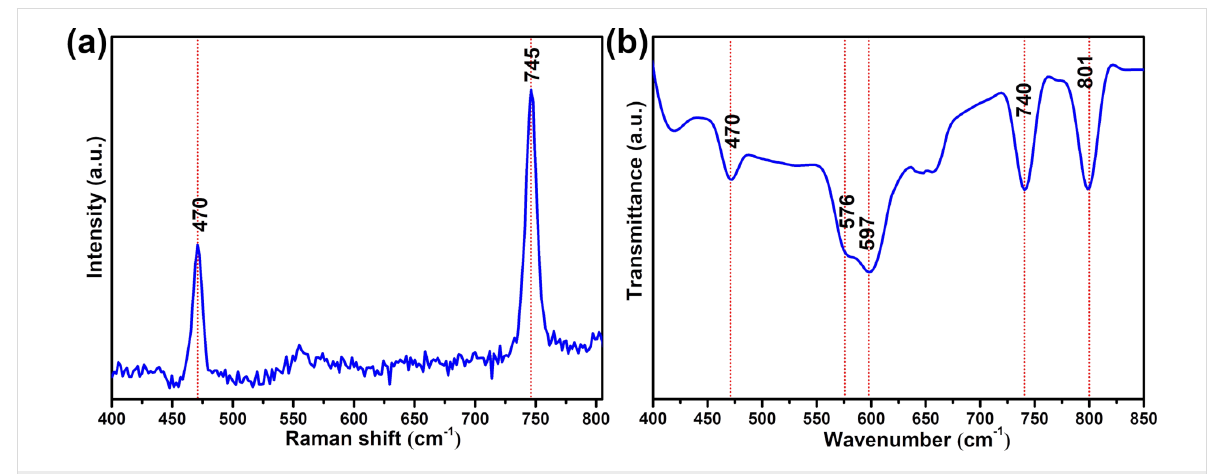
Figure 10: (a) Raman and (b) FTIR spectra of the Li 2 S 6 -treated TiO 2 /GO composite.